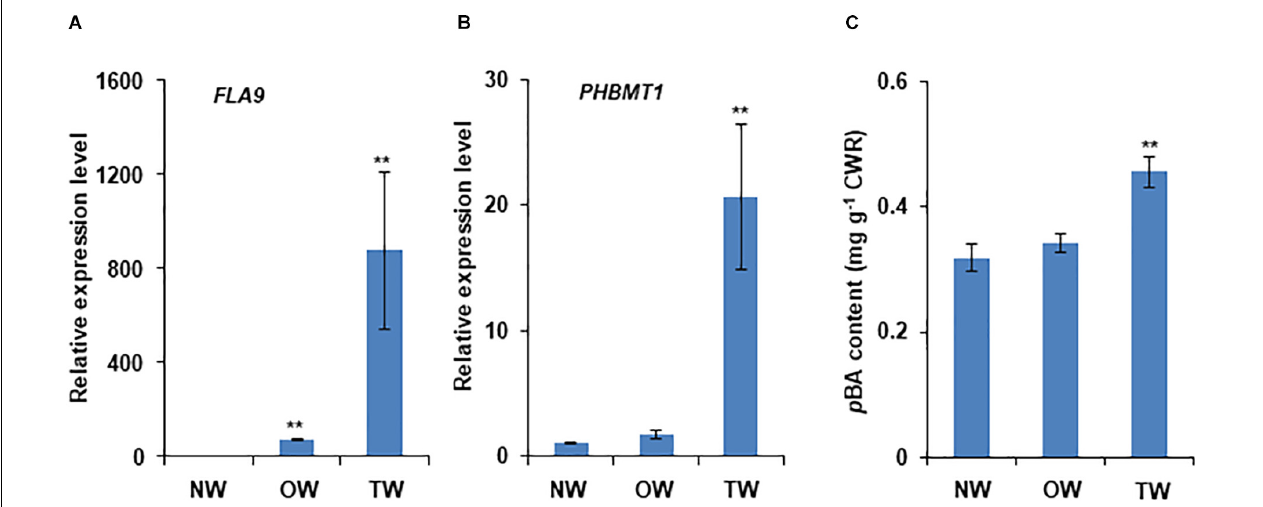
FIGURE 2 | Induction of PHBMT1 gene expression and accumulation of wall-bound p -hydroxybenzoates in poplar tension wood upon mechanical bending. One-year-old hybrid poplar tree was subjected to mechanical bending for 10 days. (A) Relative expression levels of tension wood marker gene FLA9 in normal wood (NW), opposite wood (OW), and tension wood (TW) detected via real-time quantitative PCR (qRT-PCR). The expression level in NW is set as 1 and the actin gene as the reference. (B) Relative expression levels of PHBMT1 in NW, OW, and TW. The expression level in NW is set as 1 and the actin gene as the reference. (C) Content of the alkaline-released wall-bound p -hydroxybenzoates ( p BAs) in the developing xylem of NW, OW, and TW. CWR, cell wall residue. Data in (A–C) represent the mean ± SD of three biological repeats. Asterisk indicates significant difference compared to the corresponding NW, ** P < 0.01 (Student’s t